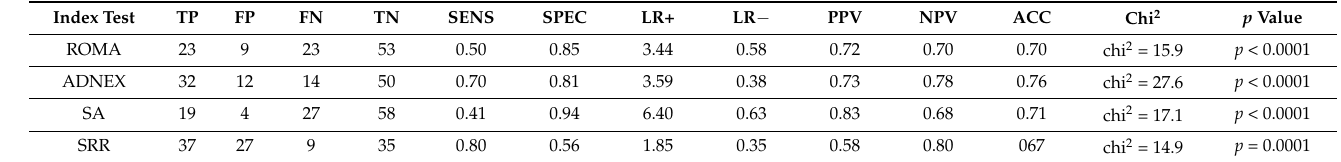
Table 6. Predictive values of the ROMA, ADNEX, SA and SRR in the group of 62 women with benign masses compared to 46 patients with borderline or early stage malignant adnexal